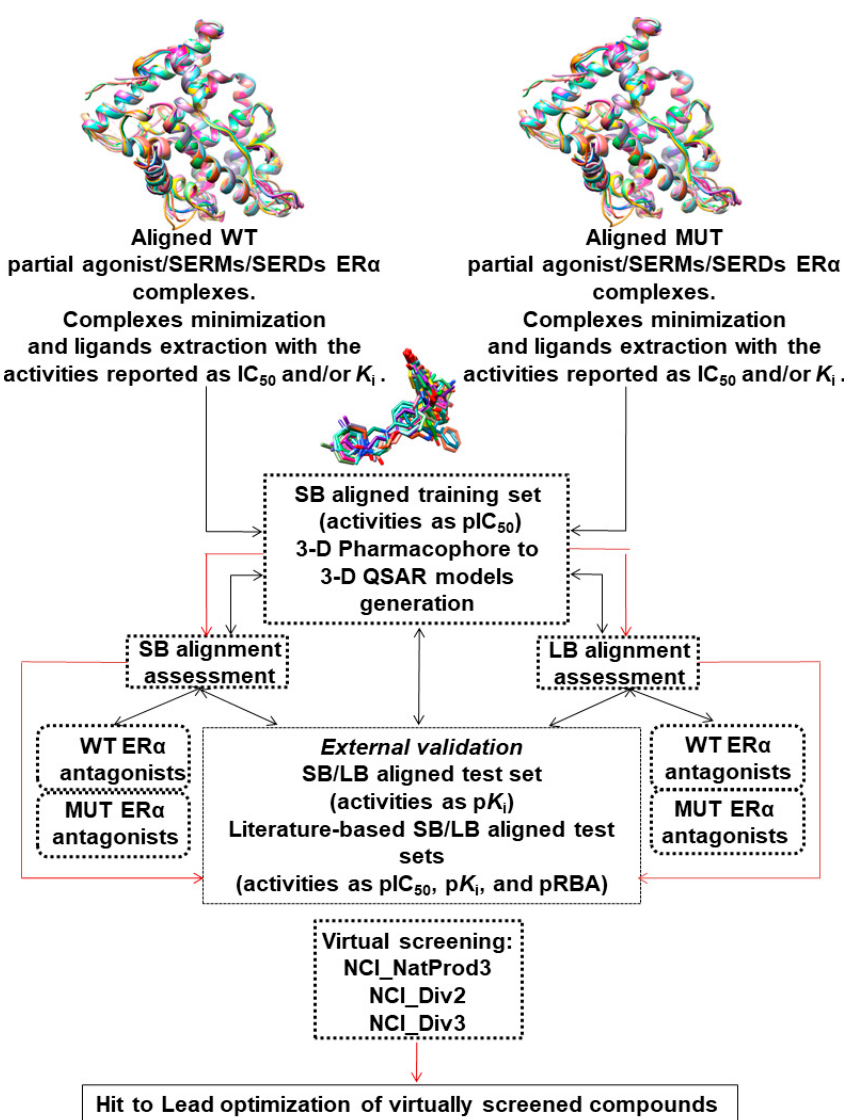
Figure 3. The overall procedure workflow used for the definition of the 3-D pharmacophore/3-D QSAR models and their analysis is depicted as a “black” pathway. The application of generated 3-D pharmacophore/3-D QSAR models in structure-based and ligand-based virtual screening is depicted as a “red” pathway.